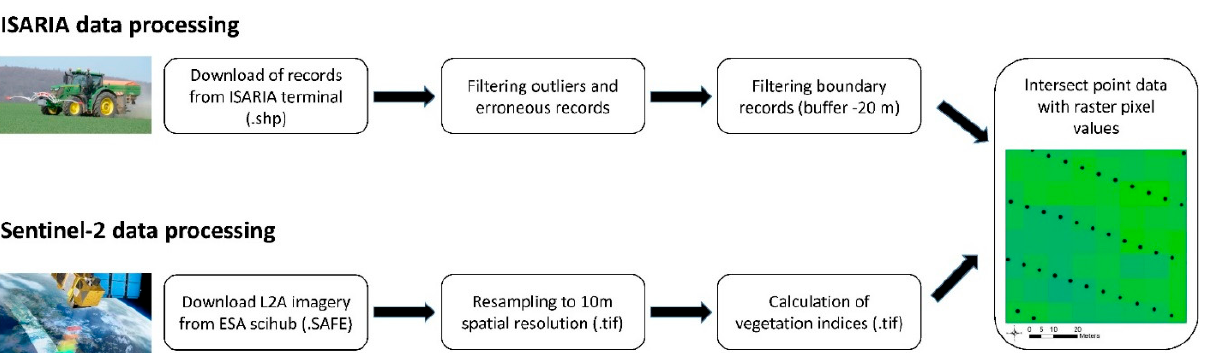
Figure 4. Flowchart of data processing and analysis in the study. Includes ISARIA point data and Sentinel-2 raster imagery pre-processing procedures in GIS and the overlay analysis of point and raster datasets.